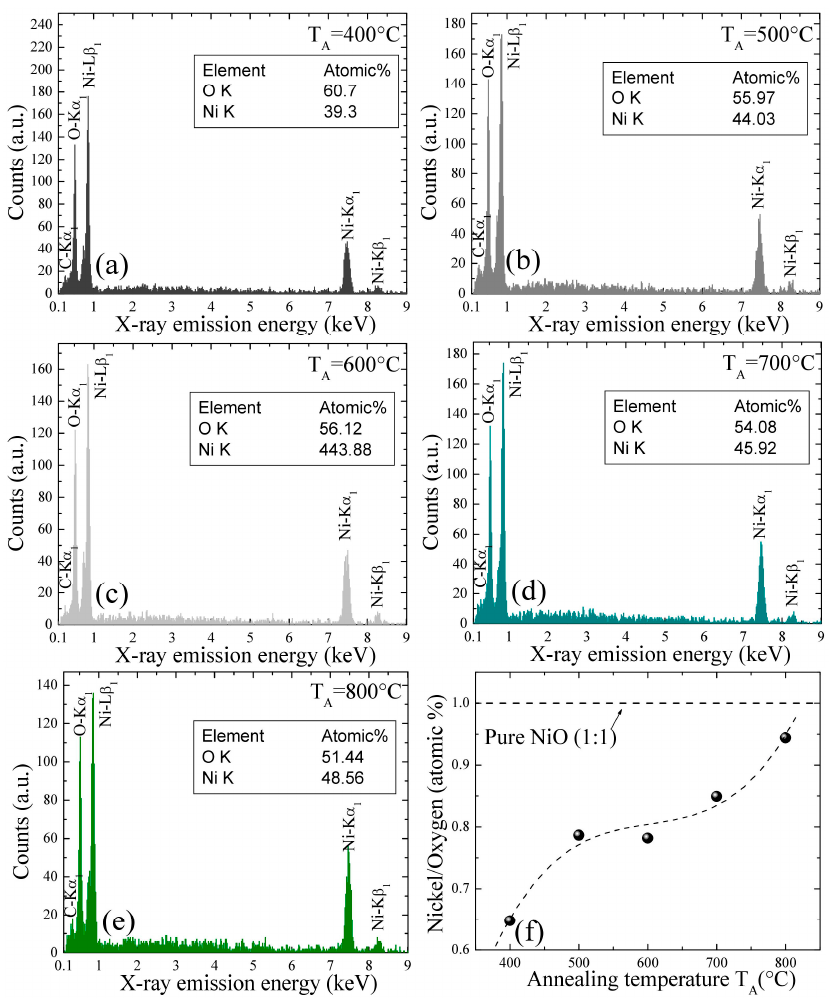
Figure 3. ( a – e ) Plots of typical EDS spectra taken from various NiO samples; ( f ) the Ni/O atomic percentage ratio with respect to annealing temperature obtained using EDS.